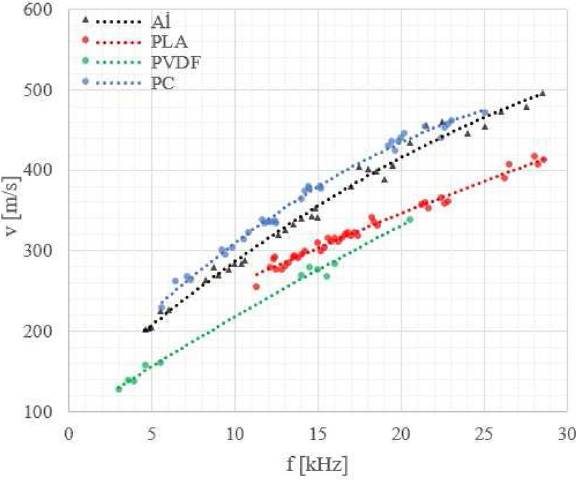
Figure 5. Comparison of the Lamb wave phase velocities for pure polymer and aluminium